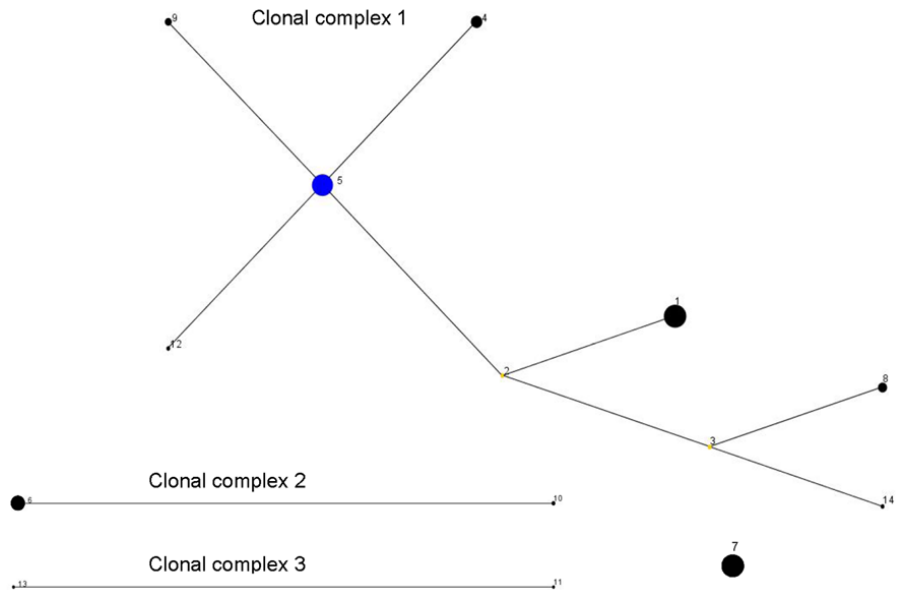
Figure 3. Phylogenetic relationship between differentB.henselaeSTs as determined by eBURST. A clonal complex contains STs that have 7 out of 8 alleles in common. ST7 is assigned as a singleton since it differed in 3–7 alleles from all other STs. The size of the circles relates to the frequency of the corresponding ST, and illustrates that the assigned primary founder of the major clonal complex (ST5) is a common clone.